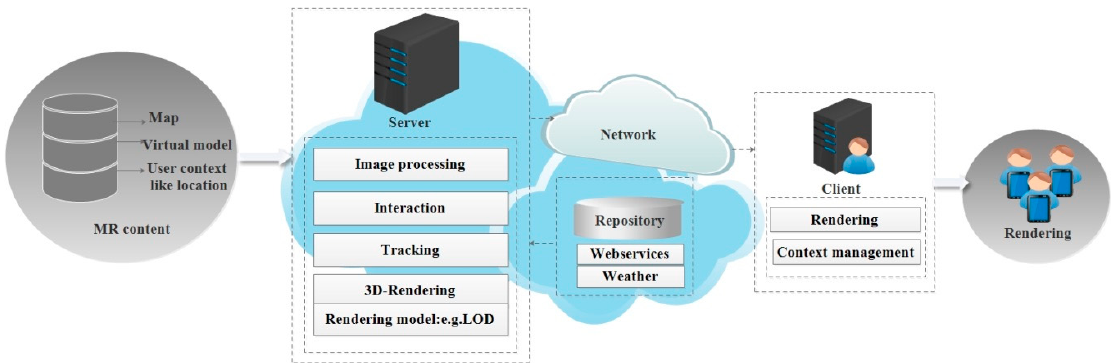
Figure 6. General architecture of mixed reality system.